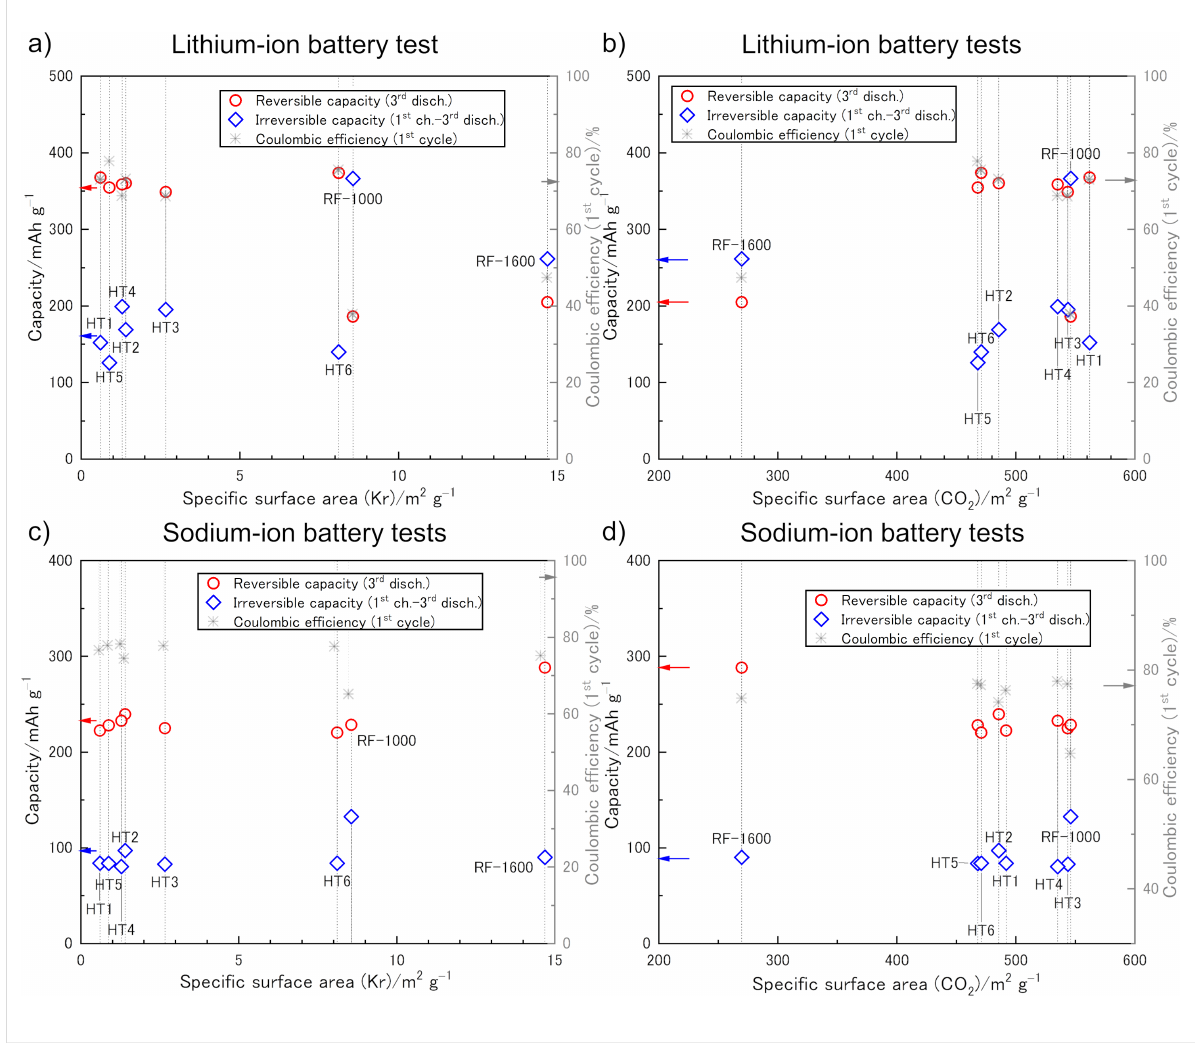
Figure 3: Capacities (reversible: red circle, irreversible: blue diamond, Y -axis) and Coulombic efficiencies (gray asterisk, R -axis) against SSA ob- tained from Kr (a, c) and CO 2 (b,d) adsorption isotherms of lithium (a, b) and sodium (c, d).